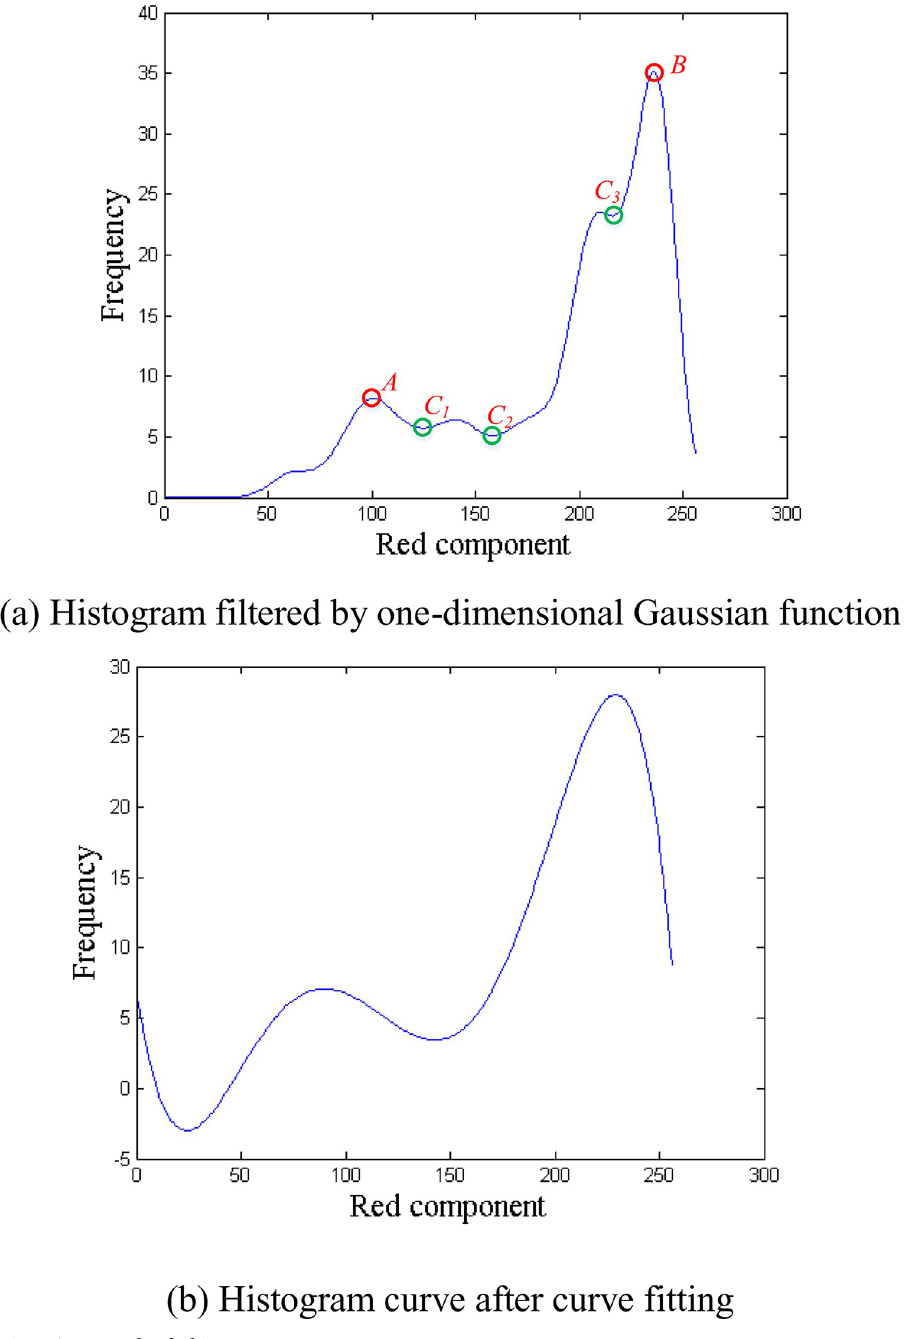
After the refined segmentation, we obtain the grain connected regions of different sizes. The number of pixels contained in the connected region can be regarded as the area of the region, denoted as s . In addition, the area of a single grain is denoted as s